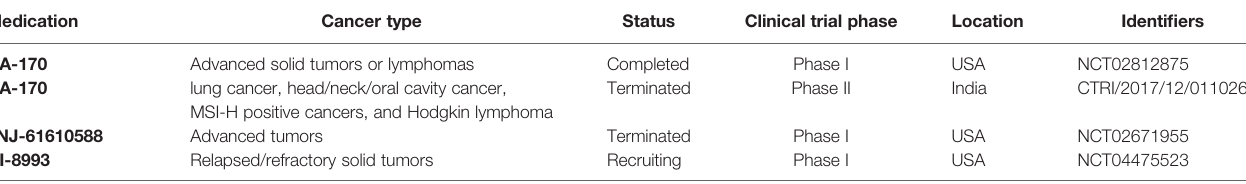
Table 1 aims to summarize the clinical trials evaluating the ef fi cacy and safety of VISTA blockade in various cancers. CA-170, an orally administered agent, can directly target PD-L1, PD-L2, and VISTA that lead to IFN- g release ( Figure 3 ). Phase I of this agent was tested on patients with solid tumors or lymphoma (NCT02812875). Besides, another clinical trial evaluates its ef fi cacy in patients with lung cancer, Hodgkin lymphoma, head and neck/oral cavity cancer, and MSI-high cancer (CTRI/2017/12/011026).